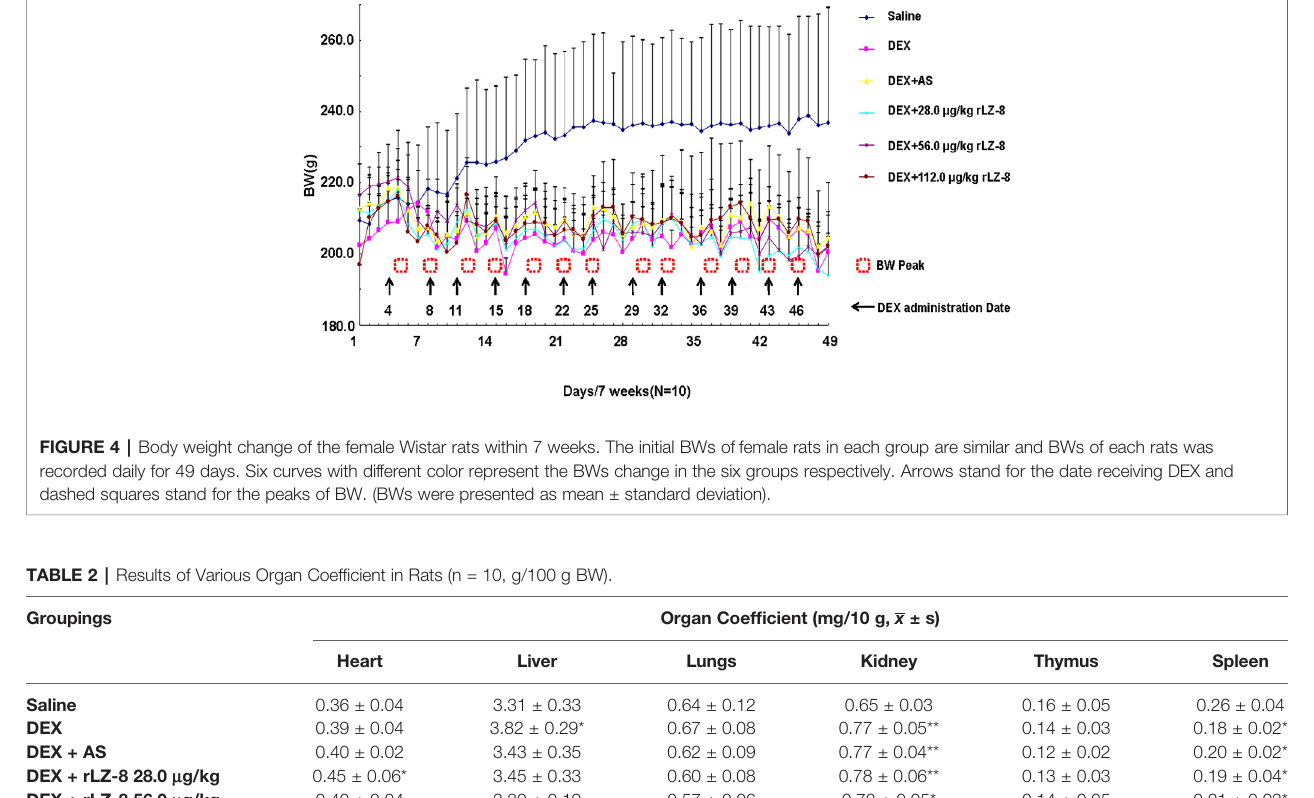
Organ coef fi cient is calculated ratio of organ weight to body weight after fasting. Comparing with saline group, the coef fi cient of heart, liver, spleen, lung, and kidney of the model group increased to a certain extent, and the thymus coef fi cient decreased. * stands for P < 0.05 ， **P <